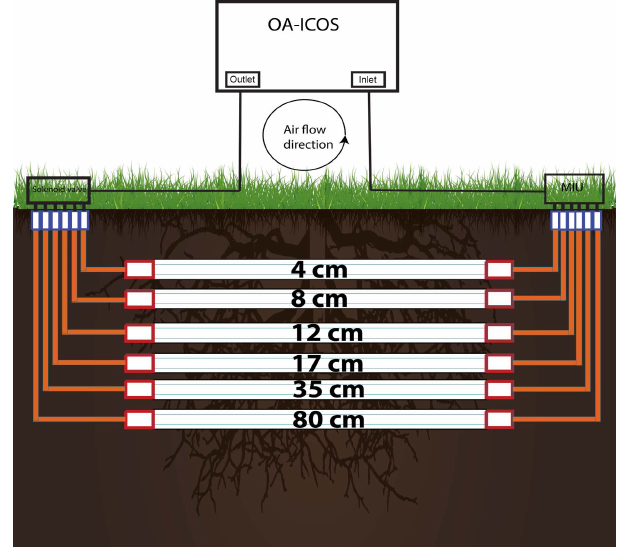
Figure 2. Installation made for soil air CO 2 (ppm), δ 13 C-CO 2 and δ 18 O − CO 2 measurements using off-axis integrated cavity output spectrometer (OA-ICOS). Hydrophobic membrane tubing was in- stalled horizontally in soil at different depths. MIU: multiport inlet